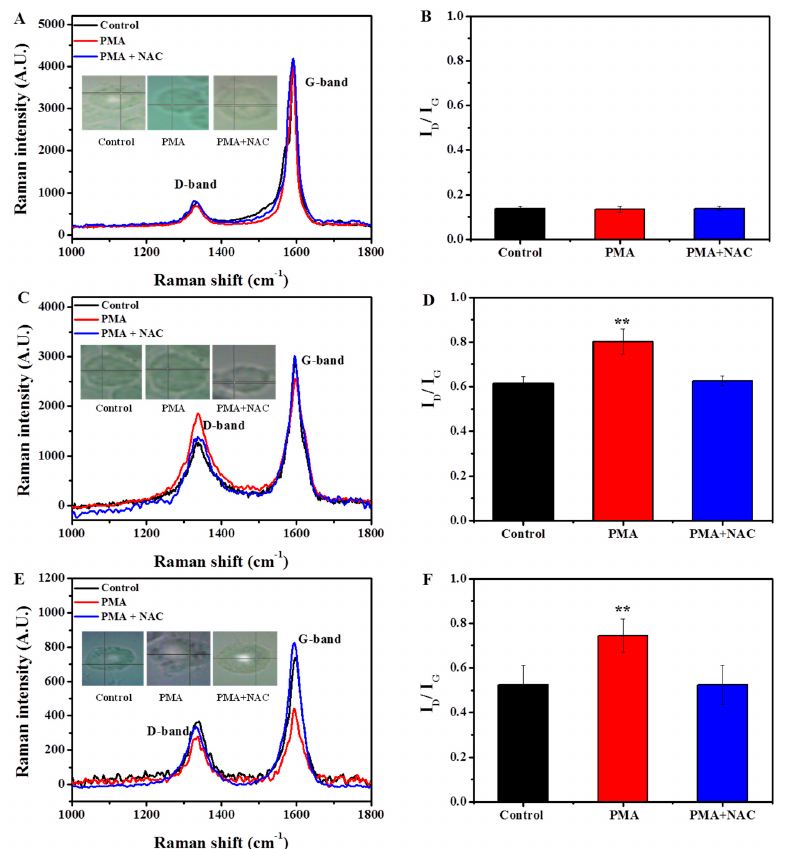
Figure 4. Biodegradation of SWCNTs by macrophages for 24 h, as characterized with Raman spectra. ( A , C , E ) Representative Raman spectra of p-SWCNTs, ox-SWCNTs, and OH-SWCNTs incubated with un-stimulated macrophages (control, black line), PMA-activated macrophages (PMA, red line), and PMA-activated macrophages with NAC treatment (PMA + NAC, blue line) for 24 h. Corresponding cell images and sampling sites were shown as insets; ( B , D , F ) Quantitative I D /I G ratios of p-SWCNTs, ox-SWCNTs, and OH-SWCNTs treated in ( A , C , E ), respectively. The results were obtained from at least 20 spectra and expressed as mean ± S.D. (standard deviation). (** p < 0.01).